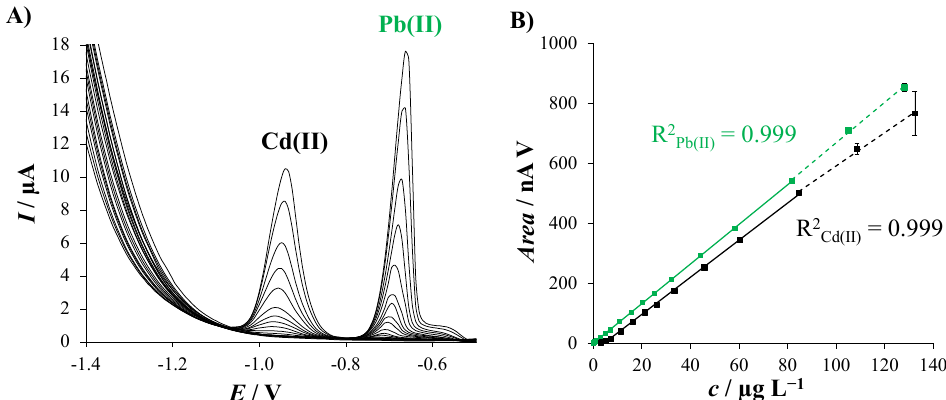
Figure 4. ( A ) DPASV responses of 2D Sb exf -SPCNFE for the simultaneous determination of increasing concentrations of Pb(II) and Cd(II) ions at pH 2, E d of − 1.4 V and t d of 240 s; and ( B ) corresponding calibration curves. Solid lines indicate the data used to calculate the linear ranges. Three replicates were considered to calculate the error bars. Table 1. Comparison of the analytical performance of SPCE bare , SPCNFE bare , 2D Sb exf -SPCE, and 2D Sb exf -SPCNFE for the simultaneous determination of Pb(II) and Cd(II) by DPASV at pH 2, E d of − 1.4 V and t d of 240 s. The standard deviations are shown within brackets. SPCE bare SPCNFE